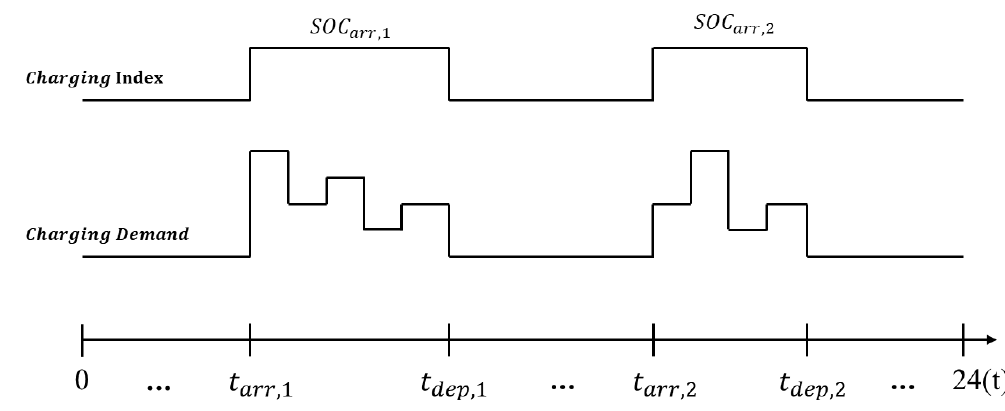
Figure 1. Probability Generation Modeling Schematic.